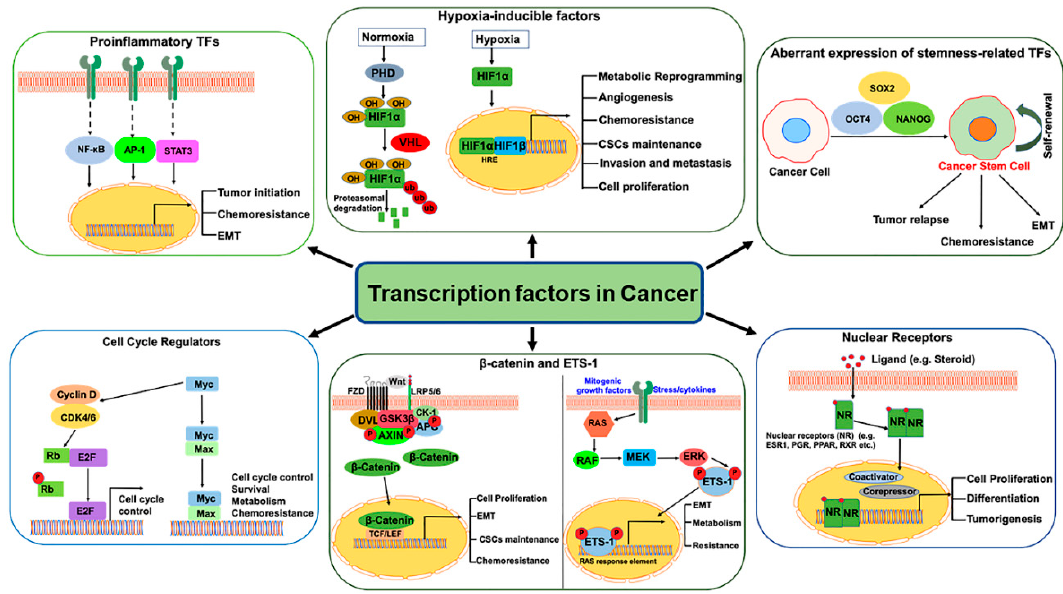
Figure 1. Schematic diagram representing the transcription factors activated in cancer to regulate the expression of genes involved in tumor growth, metastasis, chemoresistance, epithelial–mesenchymal transition (EMT), metabolism and Cancer Stem Cells (CSCs) maintenance.